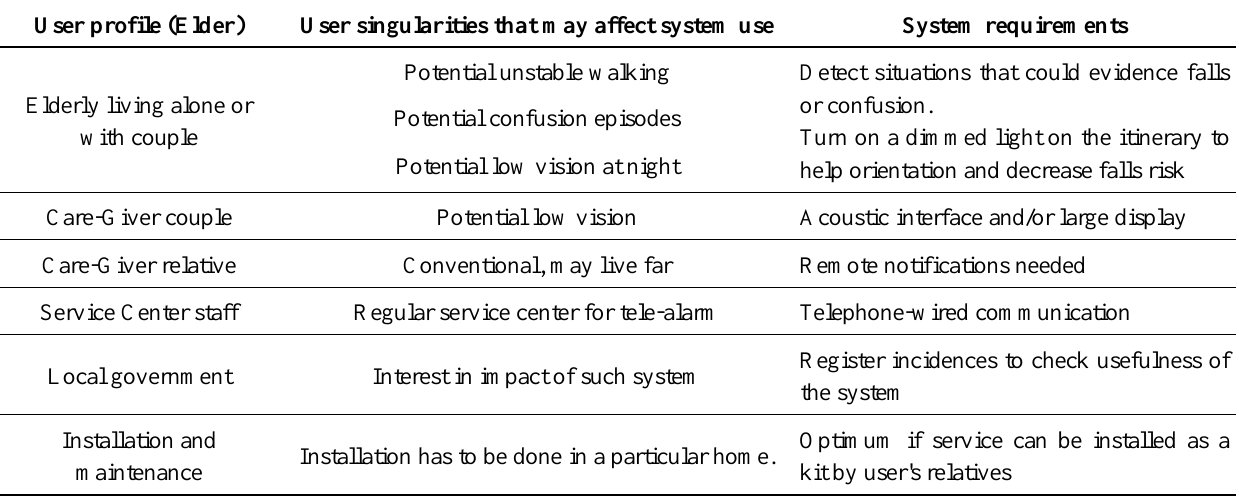
Table 5. Analysis of user needs and system requirements regarding user capacities.